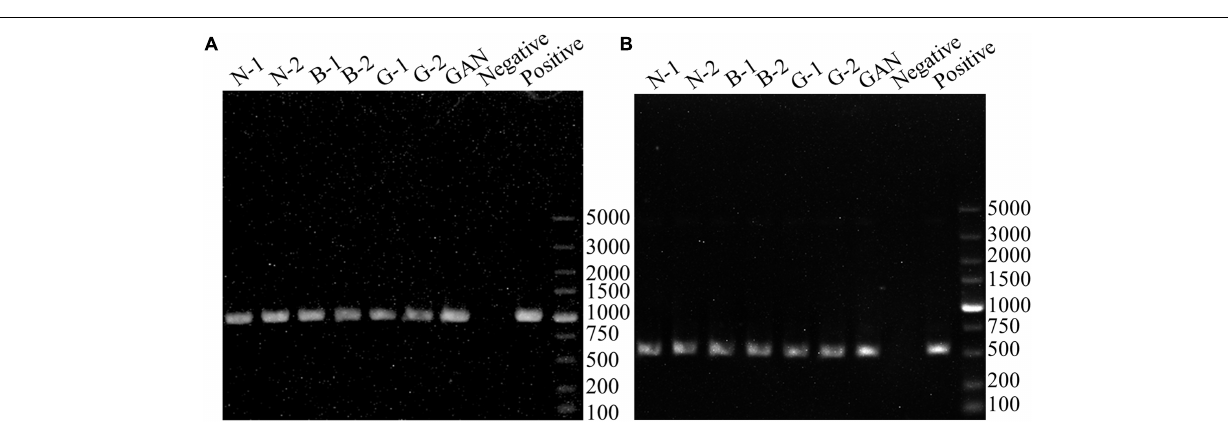
higher than that of agmatine in our selected strains ( Table 4